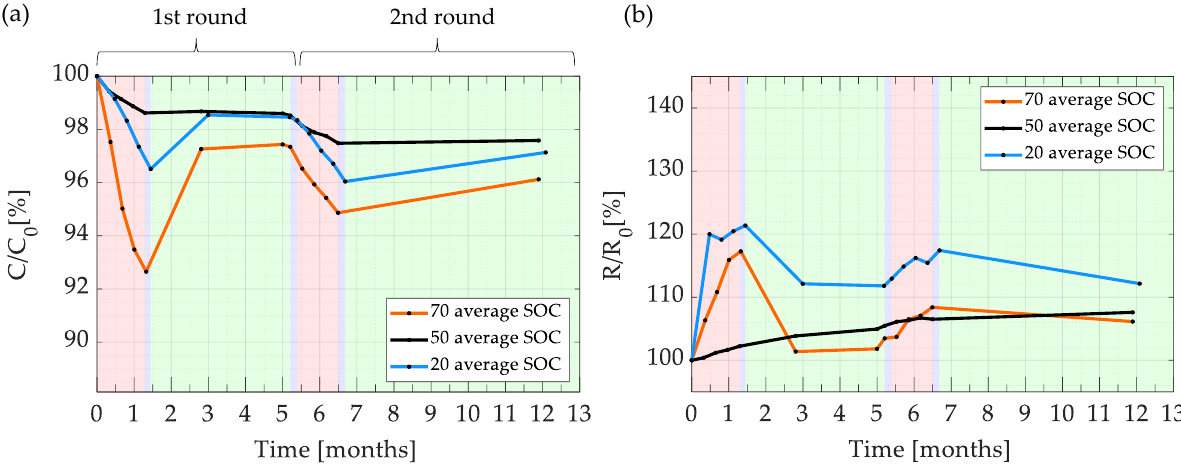
Figure 3. Capacity loss ( a ) and pulse resistance ( b ) over time for cells cycled at 20% (blue), 50% (black), and 70% (orange) average SOC. All tests are conducted with 20% DOD and charge/discharge currents of 1360/2800 mA. Cycling, transition, and resting phases are depicted with red, blue, and green backgrounds, correspondingly.